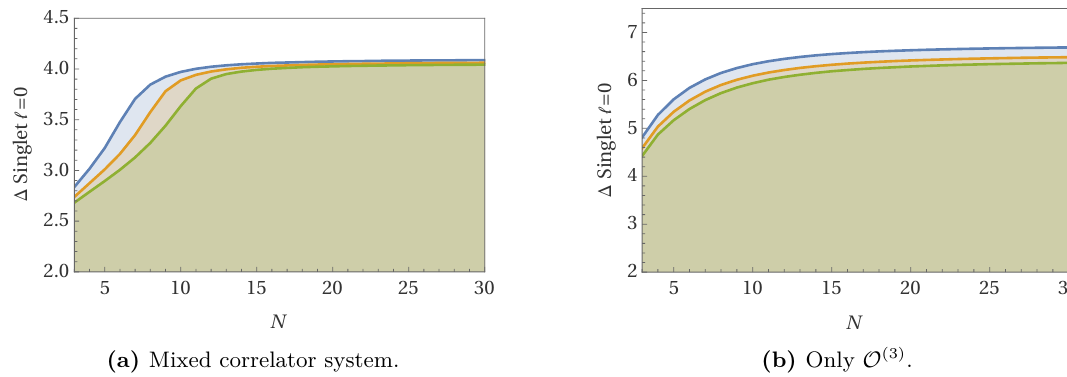
Figure 2. In the left we see the upper bound for the gap on the dimension of the scalar singlet as a function of N . The different curves are the different values of Λ = 19 , 23 , 27 . The right shows the same plot using only hO (3) O (3) O (3) O (3) i (note the difference in the scale).